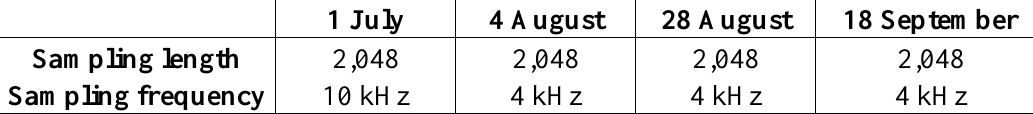
Table 4. The sampling parameters of historical data in each